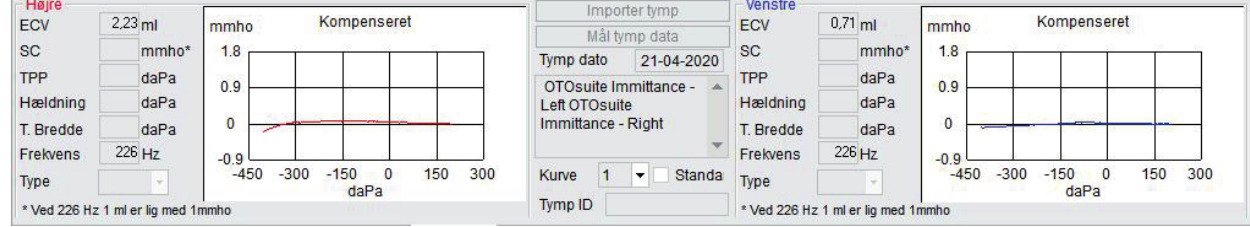
Figure 2. Tympanogram prior to initiation of Dupilumab. Type B curves with relatively small ear canal volumes (ECV) indicating fluid filled middle ears are seen on both right and left side (red and blue